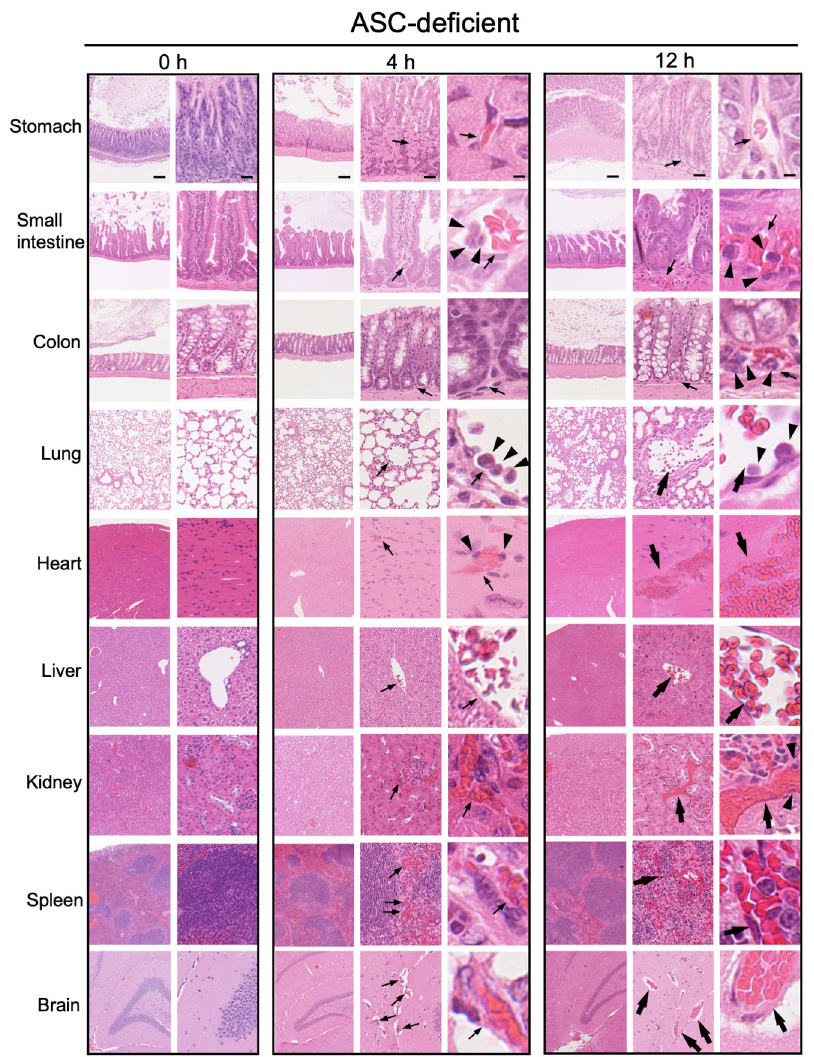
Fig 4. Histopathological images of tissues from AD mice after LPS challenge. Each image is representative of five mice. HE-stained images of the stomach, small intestine, colon, lung, heart, liver, kidney, spleen, and brain tissue from AD mice at 0 (0 h), 4 (4 h), and 12 hours (12 h) after LPS challenge. Capillary dilation is indicated by small arrows. Congestion is indicated by large arrows. Neutrophils are indicated by arrowheads. Bars, 100 μ m (low power view), 25 μ m (medium power view) and 5 μ m (high power